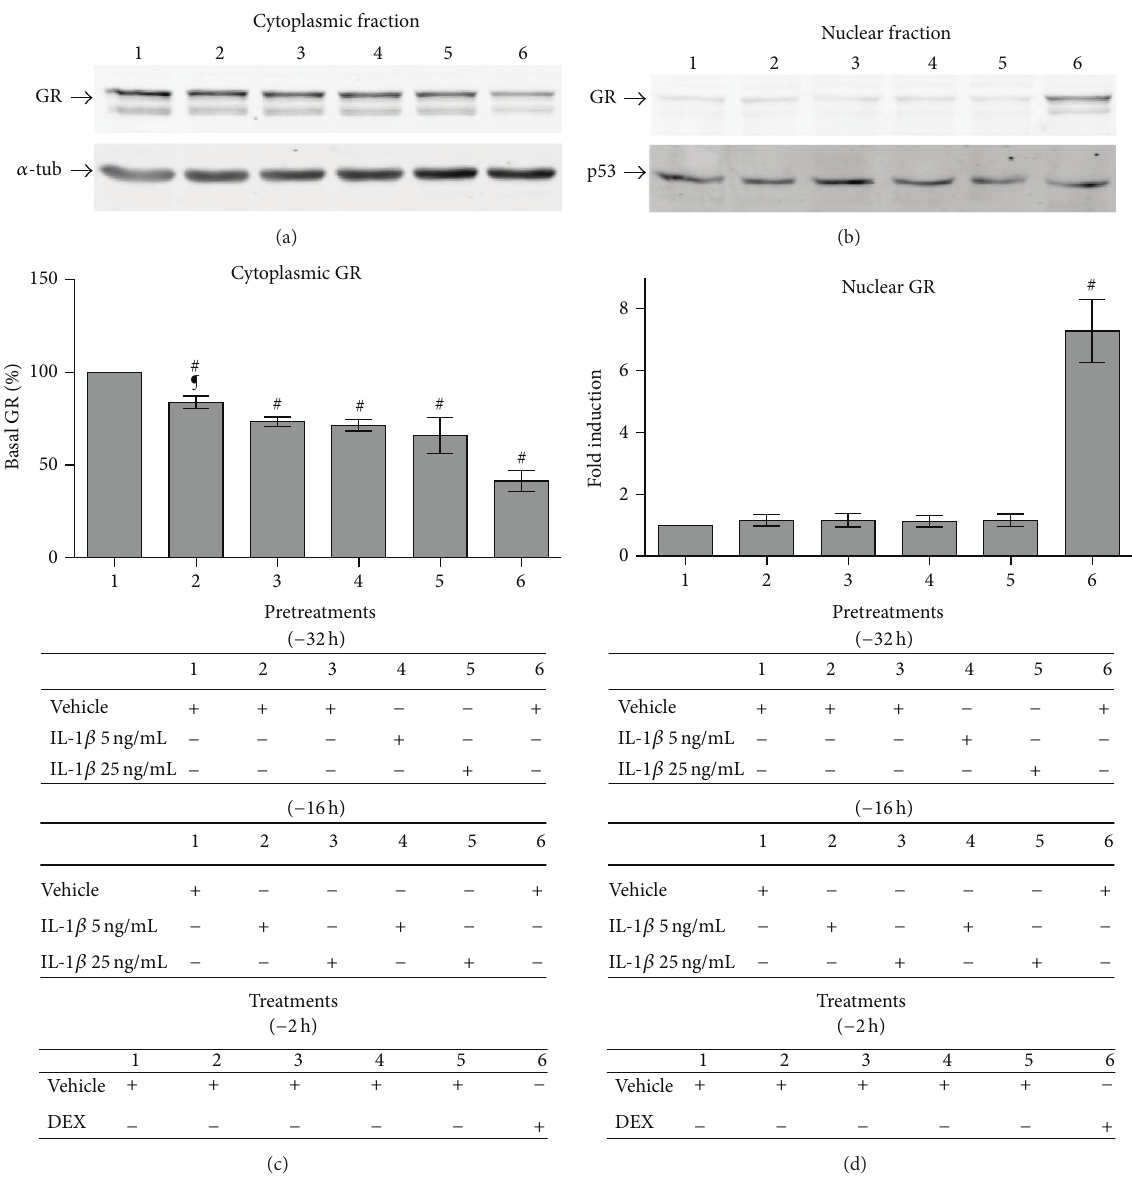
Figure 3: IL-1 𝛽 alone reduces cytoplasmic GR protein levels without promoting GR nuclear translocation. Cells were pretreated at − 32h and − 16h with vehicle, 5 or 25 ng/mL IL-1 𝛽 , and then treated the last 2h with either vehicle or 10 −8 M DEX alone, as indicated in the table: 1, 32 h in vehicle; 2, 16h veh/16h 5 ng/mL IL-1 𝛽 ; 3, 16h veh/16 h 25 ng/mL IL-1 𝛽 ; 4, 32 h 5 ng/mL IL-1 𝛽 ; 5, 32 h 25 ng/mL IL-1 𝛽 ; and 6, 30 h veh/2 h 10 −8 M DEX. The nuclear and cytoplasmic compartments were then fractionated and their lysates studied by Western blot with anti-GR antibody. Anti- 𝛼 -tubulin ( 𝛼 -tub) and -p53 antibodies are controls for the correct cytoplasmic (a) and nuclear (b) compartment fractionation, respectively, in the representative blots ( 𝑛 = 3 ). Quantitation of cytoplasmic (c) and nuclear (d) GR protein by densitometry. Data are represented as mean ± SEM. # 𝑃 < 0.05 , differences in cytoplasmic GR protein content between cells treated with 16h veh/16 h 5 ng/mL IL-1 𝛽 (c2), 16 h veh/16h 25ng/mL IL-1 𝛽 (c3), 32 h 5 ng/mL IL-1 𝛽 (c4), 32 h 25 ng/mL IL-1 𝛽 (c5), or 30h veh/2 h DEX (c6), compared with32 hvehicle-treatedcells(c1). ¶ 𝑃 < 0.05 ,differenceincytoplasmicGRproteinlevelsbetweencellstreatedwith5 ng/mL(c2)and25 ng/mL (c3) IL-1 𝛽 for the last 16h. # 𝑃 < 0.05 , difference in nuclear GR protein levels between 30 h veh/2 h DEX-treated (d6) and veh-treated cells